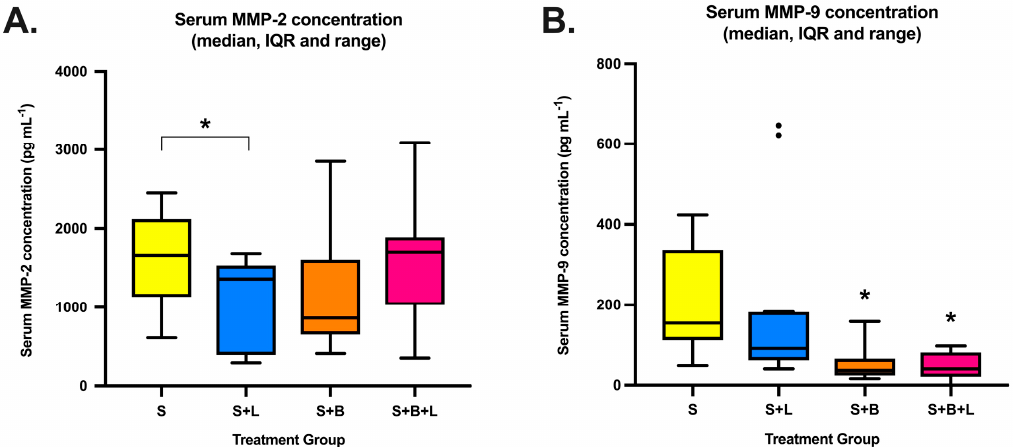
Figure 4. Serum MMP-2 ( A ) and MMP-9 ( B ) concentrations by treatment group (median, IQR and range) measured from samples at 14 days post-primary tumour excision ( n = 12 animals per group). * indicates significant difference compared to group S ( p < 0.05). • indicates outliers by Tukey’s method (>1.5 × IQR). Abbreviations: S, sevoflurane alone; S + L, sevoflurane and lidocaine; S + B, sevoflurane and bosutinib; S + B + L, sevoflurane, lidocaine and bosutinib.